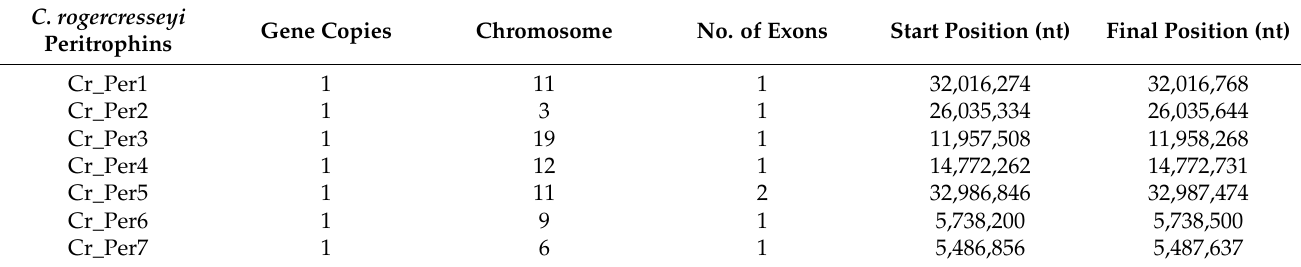
Table 2. Genome structure of C. rogercresseyi peritrophin-like.